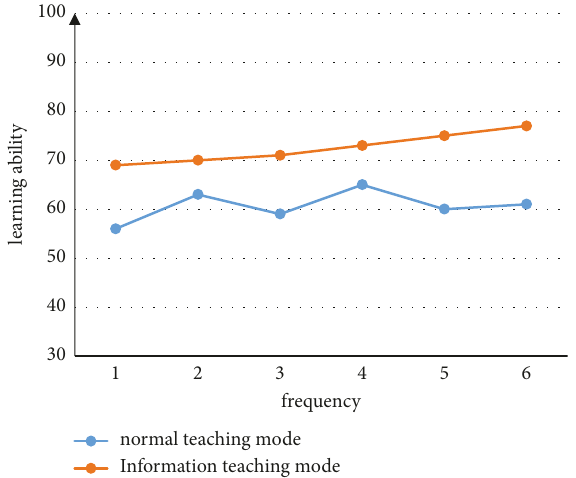
Figure 6: Comparison of different teaching modes in autonomous learning ability.